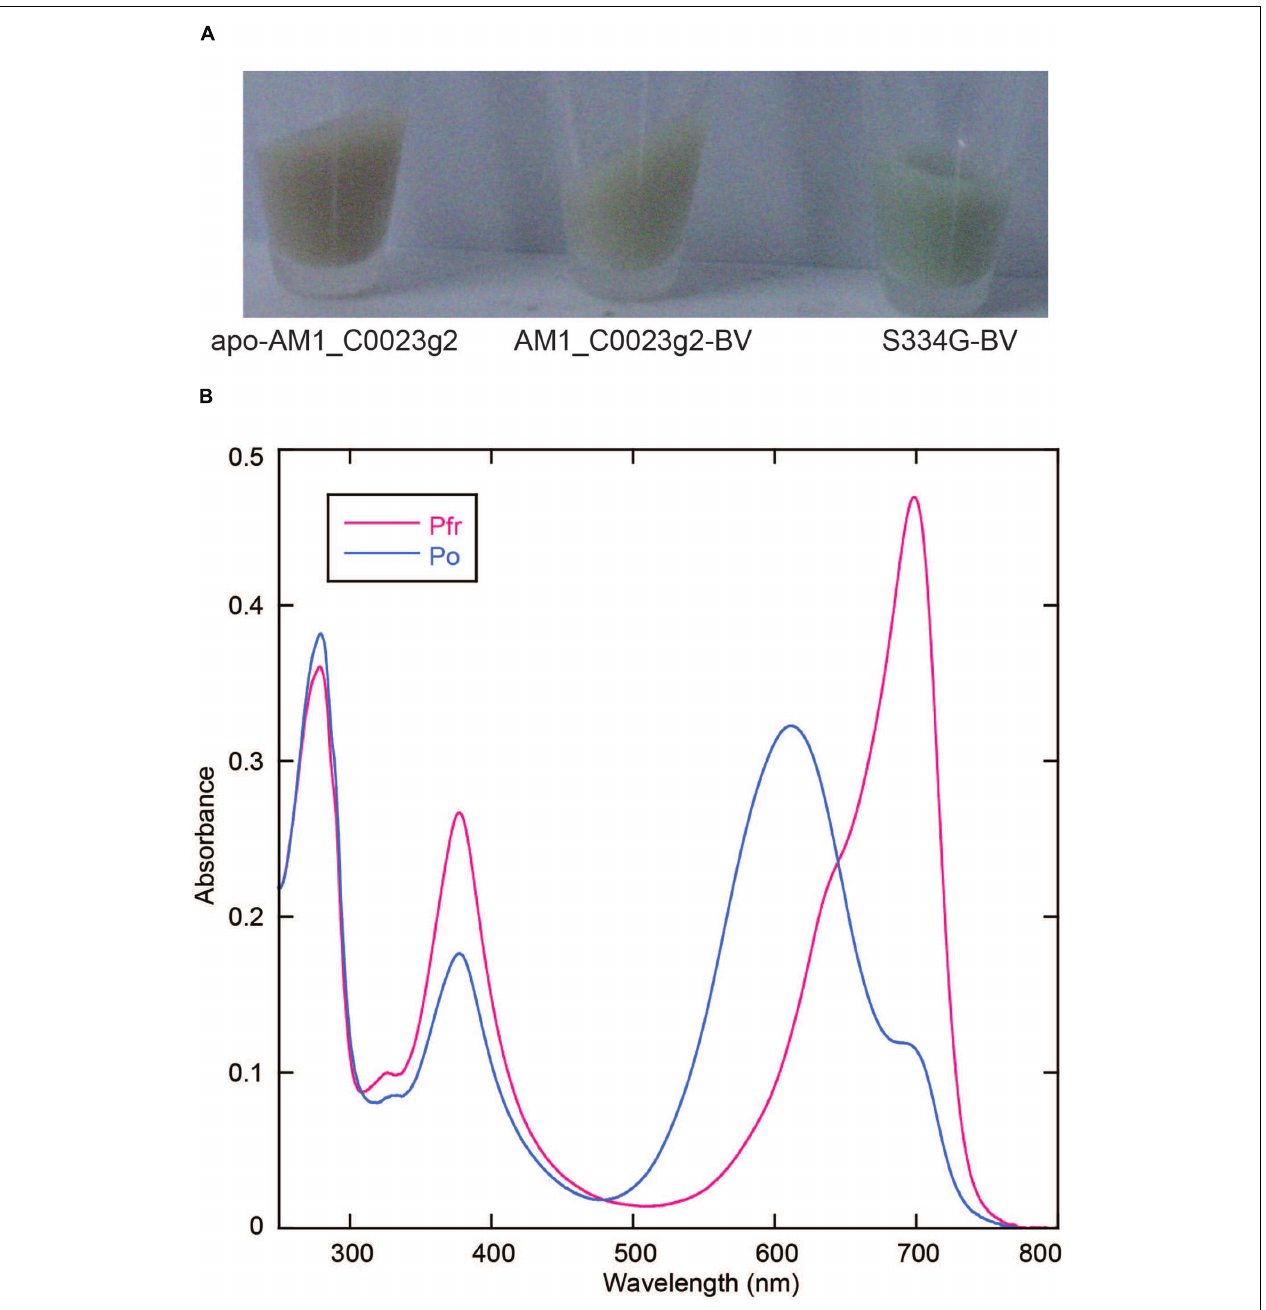
FIGURE 4 | Replacement of Ser334 of AM1_C0023g2 with Gly. (A) Photograph of cell pellets harboring apo-AM1_C0023g2, AM1_C0023g2-BV, and S334G-BV. (B) Absorption spectra of the Pfr and Po forms of